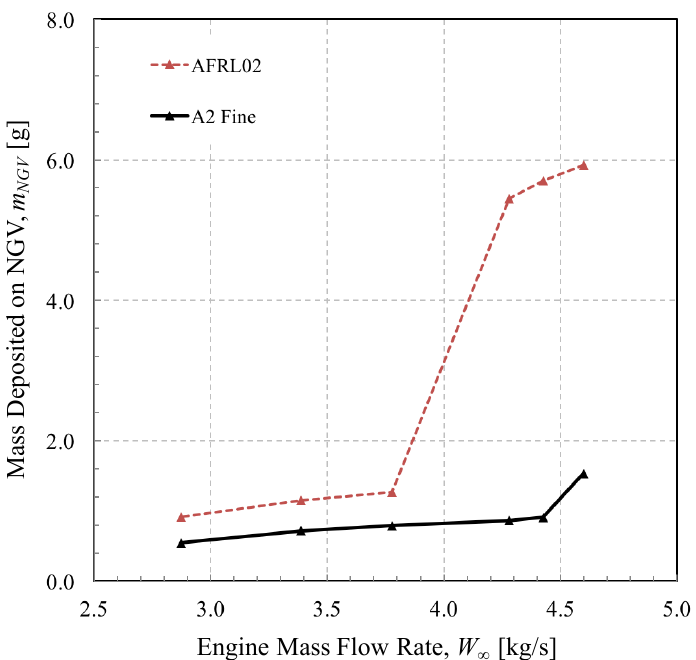
Figure 13. Effect of engine mass flow rate on the mass of material deposited during a dose of 36 gs/m 3 in a T700-GE-701c turboshaft